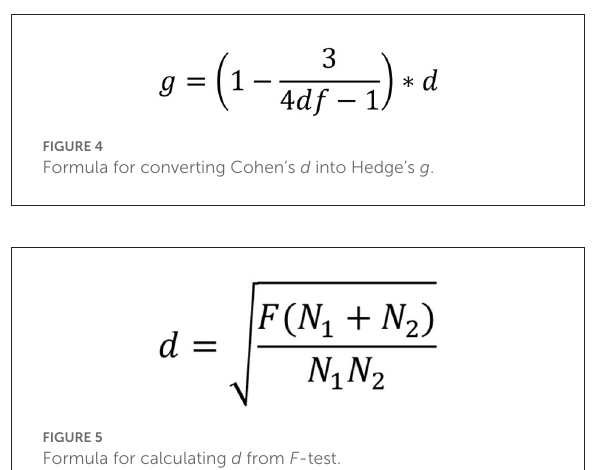
FIGURE5 Formula for calculating d from F